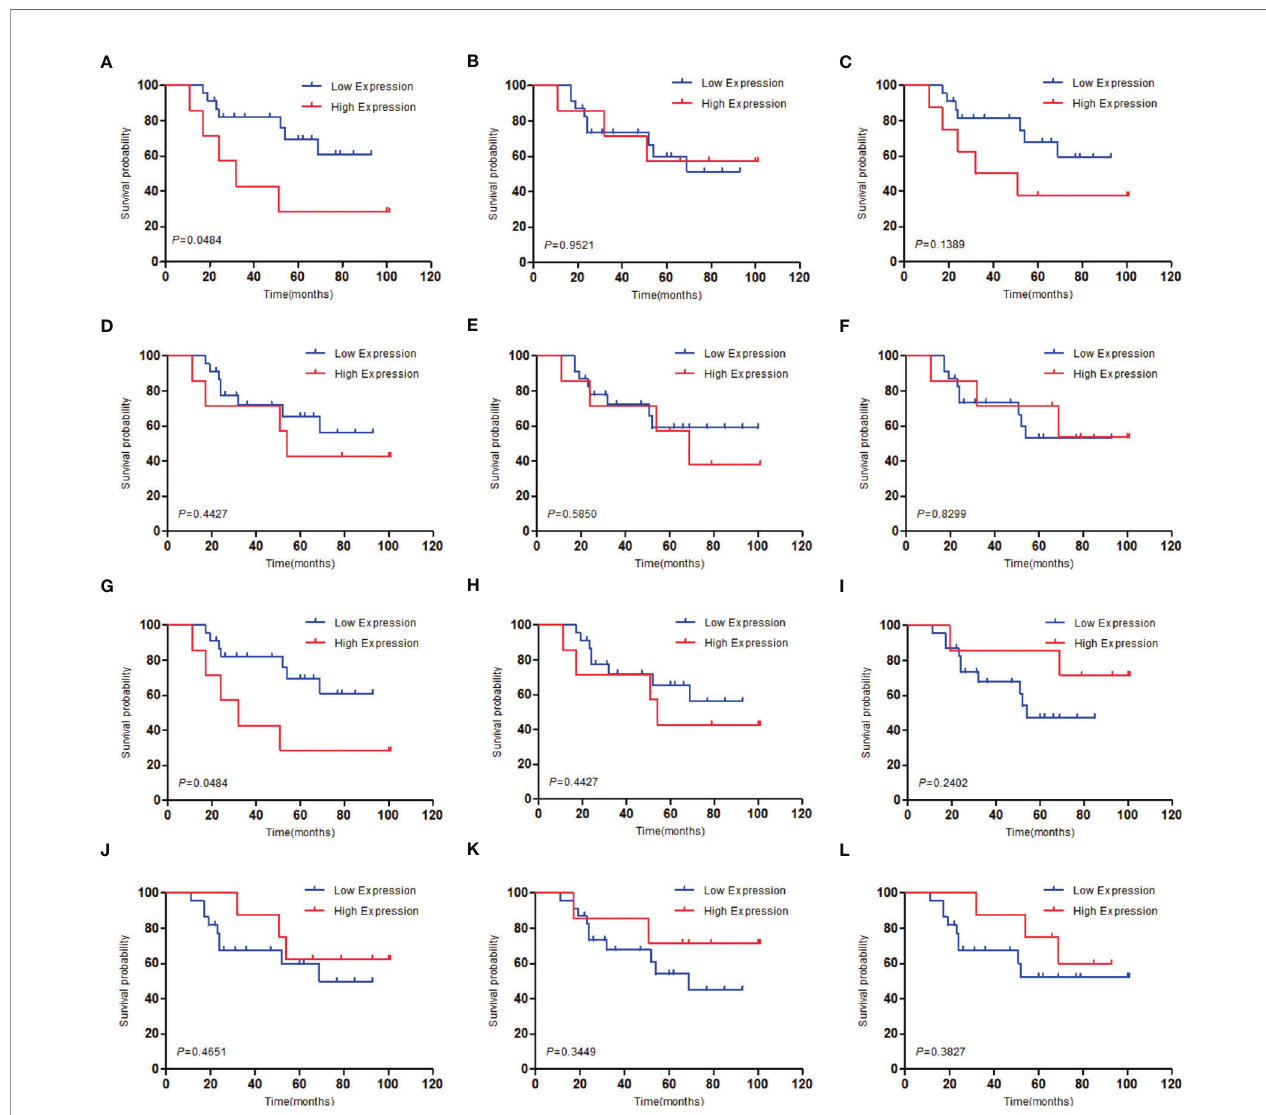
FIGURE 4 | Survival analysis of the 12 hub genes in MED based on the GSE30074 database. (A) AURKA, (B) BUB1B, (C) CCNB1, (D) CCNB2, (E) CHEK1, (F) KIF11, (G) KIF20A, (H) MAD2L1, (I) MCM6, (J) NCAPG, (K) RFC4, (L) RRM2; P < 0.05 was considered statistically signi fi